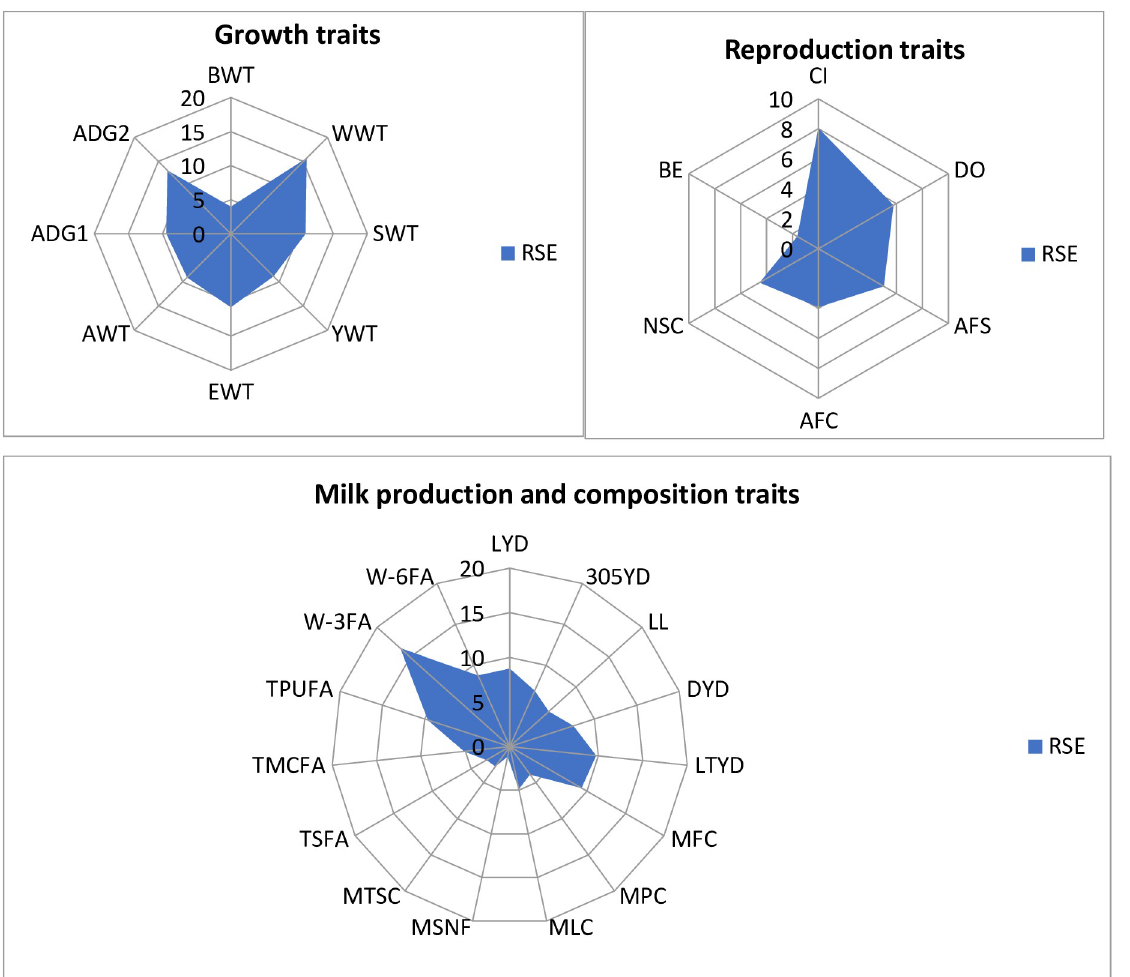
Fig 2. Box plots for relative standard errors of production and reproduction traits of Boran cattle calculated from the included search data.